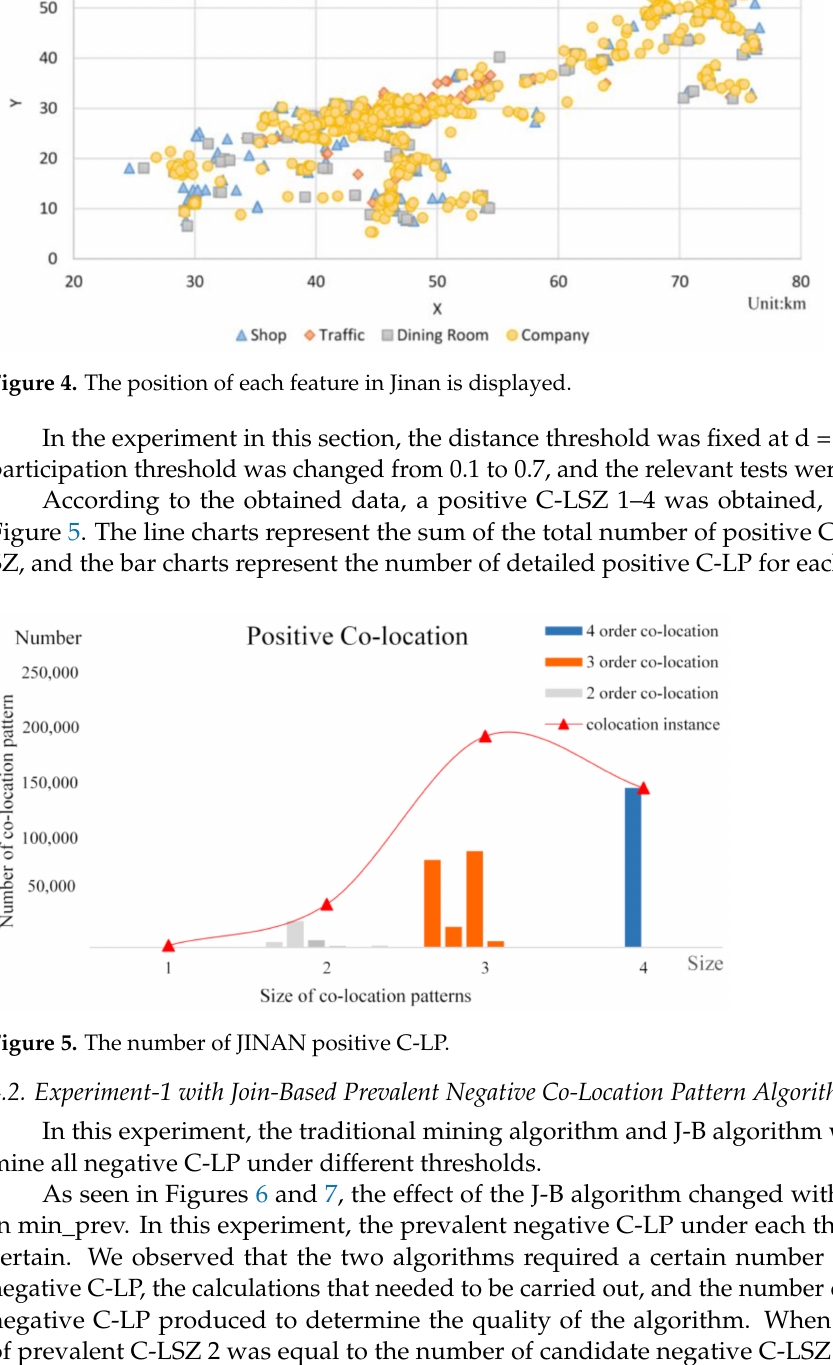
Figure 5. The number of JINAN positive